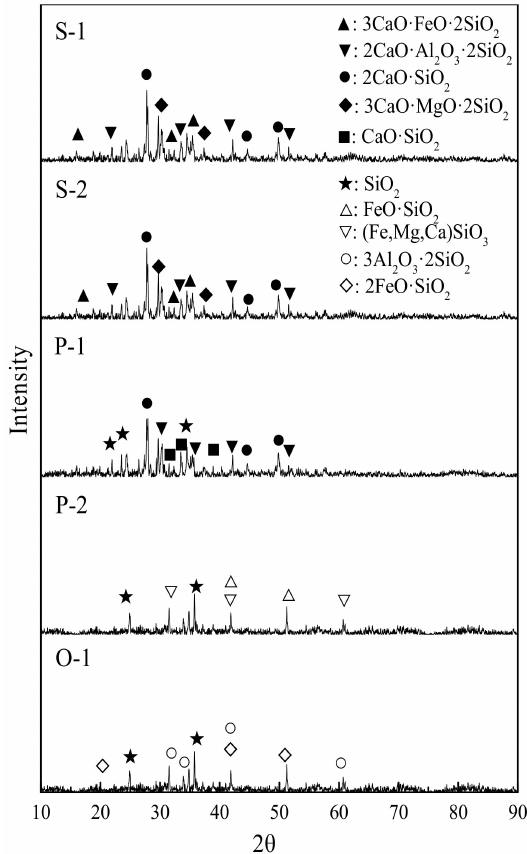
Figure 9. XRD analysis of single iron ore.